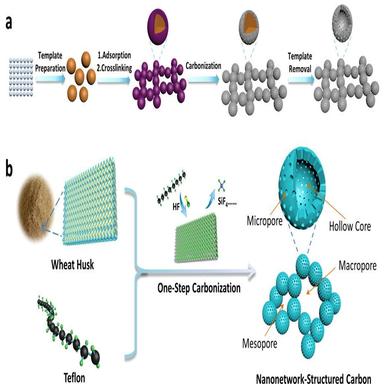
(a) Traditional processes for synthesizing NNSC with hollow nanosphere unit based on a hard-templating strategy. (b) Schematic illustration of our one-step synthetic route developed here from WHs to NNSC with hollow nanosphere unit.